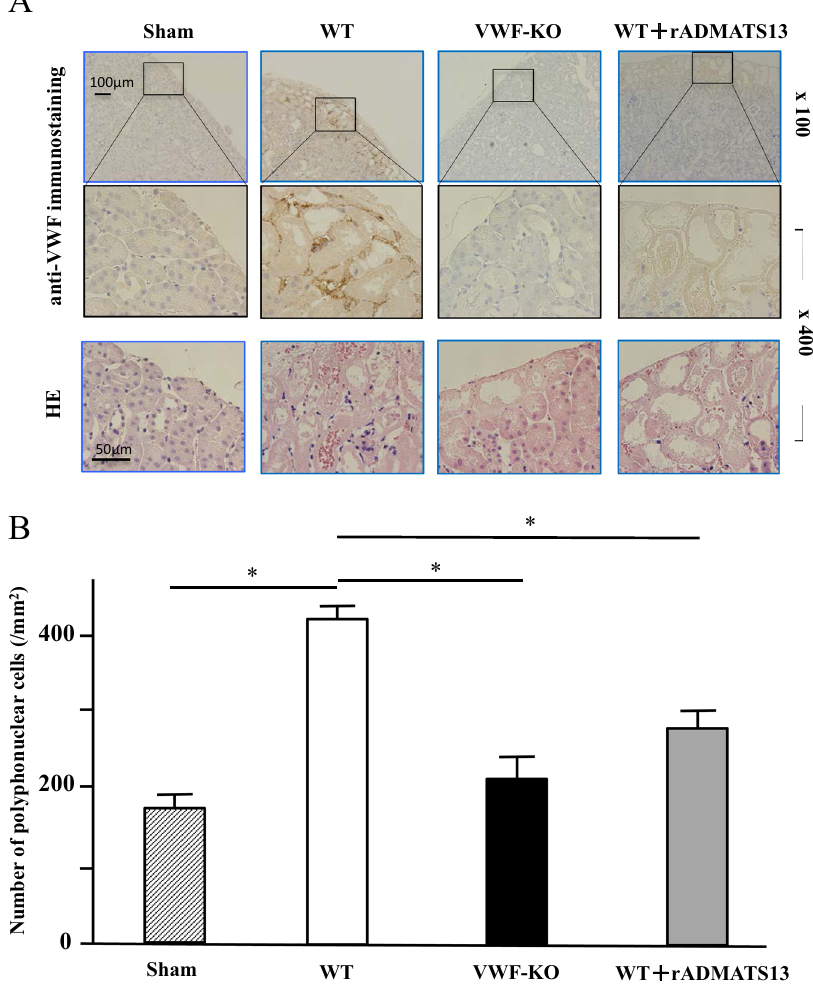
Figure 3. Histological analysis via anti-VWF immunostaining of kidney tissue in WT mice with or without rADAMTS13 infusion and in VWF-KO mice. Kidney tissues (the same as those described in the Fig. 2 legend) were subjected to immunostaining with anti-VWF antibody. ( A ) Images of kidney tissue following anti-VWF immunostaining (upper panels, original magnification, 100 × ; middle panels, enlarged images of areas enclosed in rectangles in corresponding upper panels, original magnification, 400 × ) or HE staining (lower panels, original magnification, 400 × ) are each representative of 5 independent mouse samples. Note that there is positive staining for VWF in the areas near or adjacent to necrotic tubules in WT mice, but no positive staining for VWF in VWF-KO-mice. Hardly any positive staining is seen in WT mice following ADAMTS13 injection. Like VWF staining, neutrophil infiltration around necrotic lesions is reduced in VWF-KO mice and following rADAMTS13 injection in WT mice (HE). ( B ) Statistical analyses of neutrophil accumulation corresponding to the above images; each bar represents the average ( ± SEM) of 15 areas (each 1 mm 2 ; 3 areas were randomly selected from each of 5 individual mouse tissue samples with HE staining). Note that neutrophil accumulation within kidney tissues is significantly ( * ) decreased in VWF-KO mice. Note also that rADAMTS13 injection suppresses neutrophil infiltration in WT mouse kidney. These findings suggest close relationships between VWF and both tissue neutrophil infiltration and renal tubular